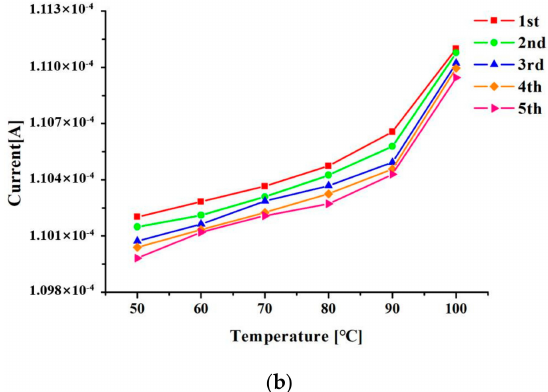
Figure 7. The graph of the relationship between the photocurrent and the temperature in the experiment of the nano-device irradiated by the heat source. ( a ) The curves of temperature and current when the heat source is continuously turned on and o ff . ( b ) The curves of temperature and current when the heat source is turned on 5